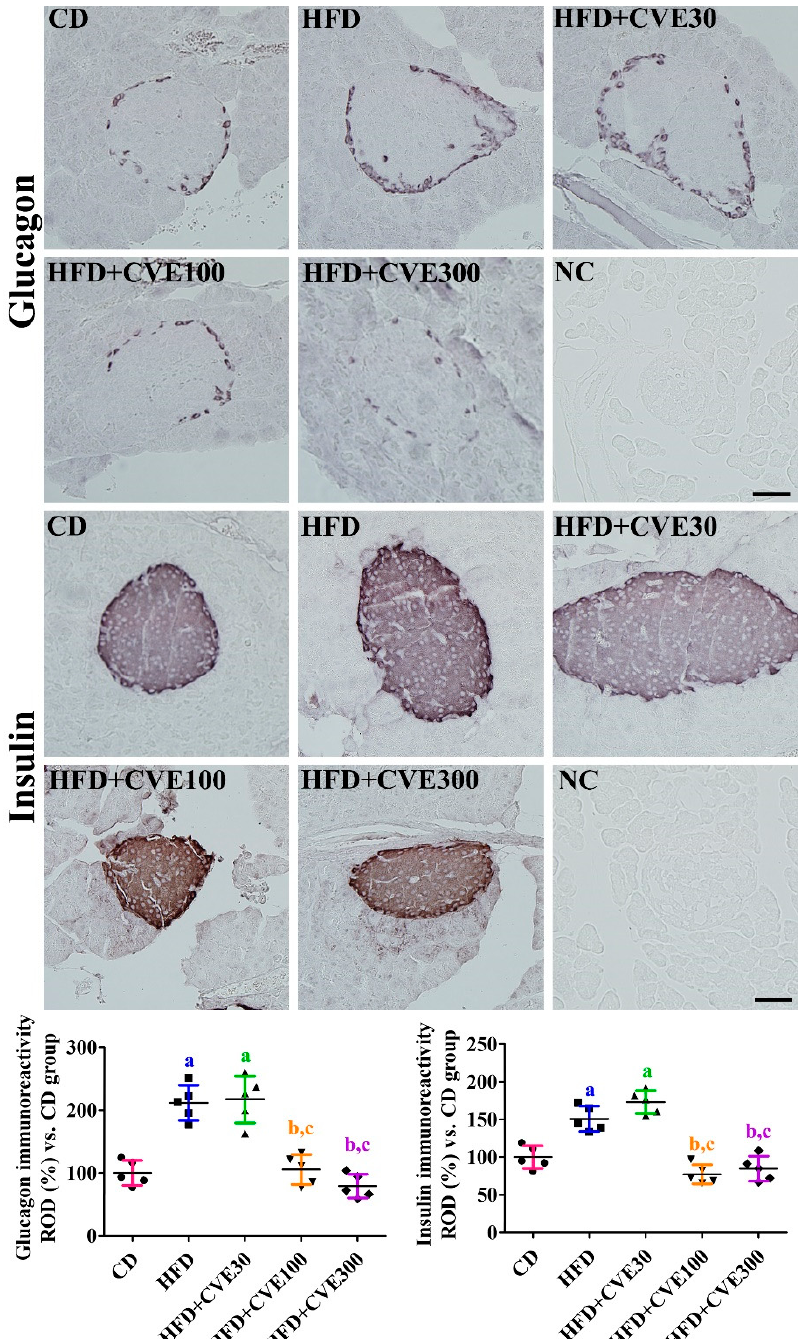
Figure 3. Immunohistochemical staining for glucagon and insulin in the pancreas of mice in CD, HFD, HFD+CVE30, HFD+CVE100, and HFD+CVE300 groups at 8 weeks after treatment. Optical density was calculated based on pixel number with gray density, and ROD is demonstrated vs. the CD group. The data were analyzed by one-way analysis of variance followed by Bonferroni’s post hoc test ( a p < 0.05, significantly different from the CD group; b p < 0.05, significantly different from the HFD group; c p < 0.05, significantly different from the HFD+CVE30 group). The bars indicate the mean ± standard deviation. CD, control diet; CVE, Cissus verticillata leaf extract; HFD, high-fat diet; NC, negative control staining; ROD, relative optical density.